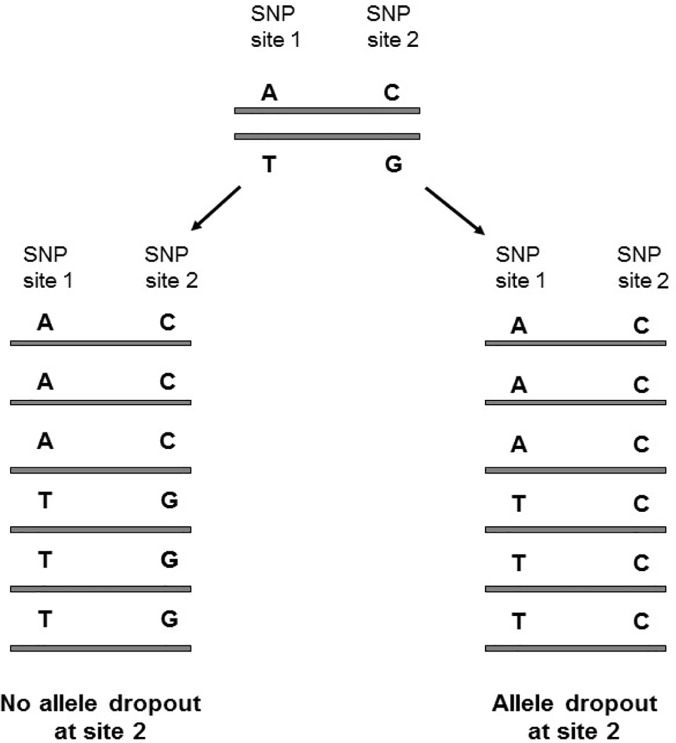
Assessing the strategy of defining allele dropout using neighboring SNPs.We considered a total of 2,320 germ-line SNP pairs in which both SNP sites were heterozygous in the patient and also <90 bp away from each other and analyzed the exome data of 80 single tumor Myeloproliferative Neoplasm cells. When there are two alleles (such as AC, TG) without allele dropout at SNP site 1, the genotype of SNP site 2 can be recovered at an error rate of 4.94×10–5.